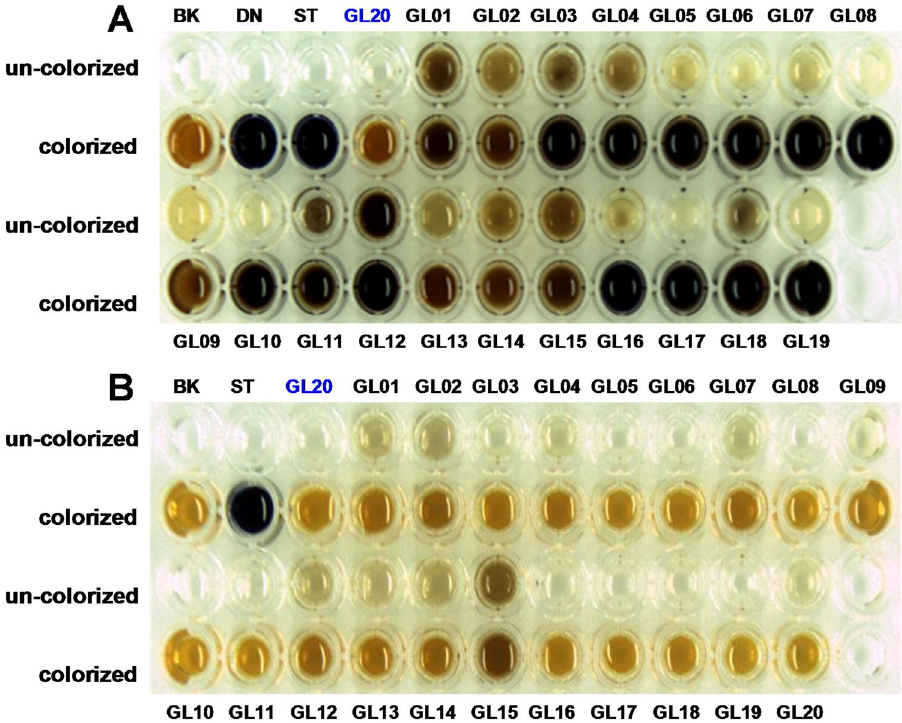
Figure 2. Colorimetric assay of polysaccharides in G . lucidum dietary supplements before ( A ) and after ( B ) α -amylase digestion. BK , water used as blank control; DN , malto-dextrin; ST , starch. Sample codes were the same as in Table